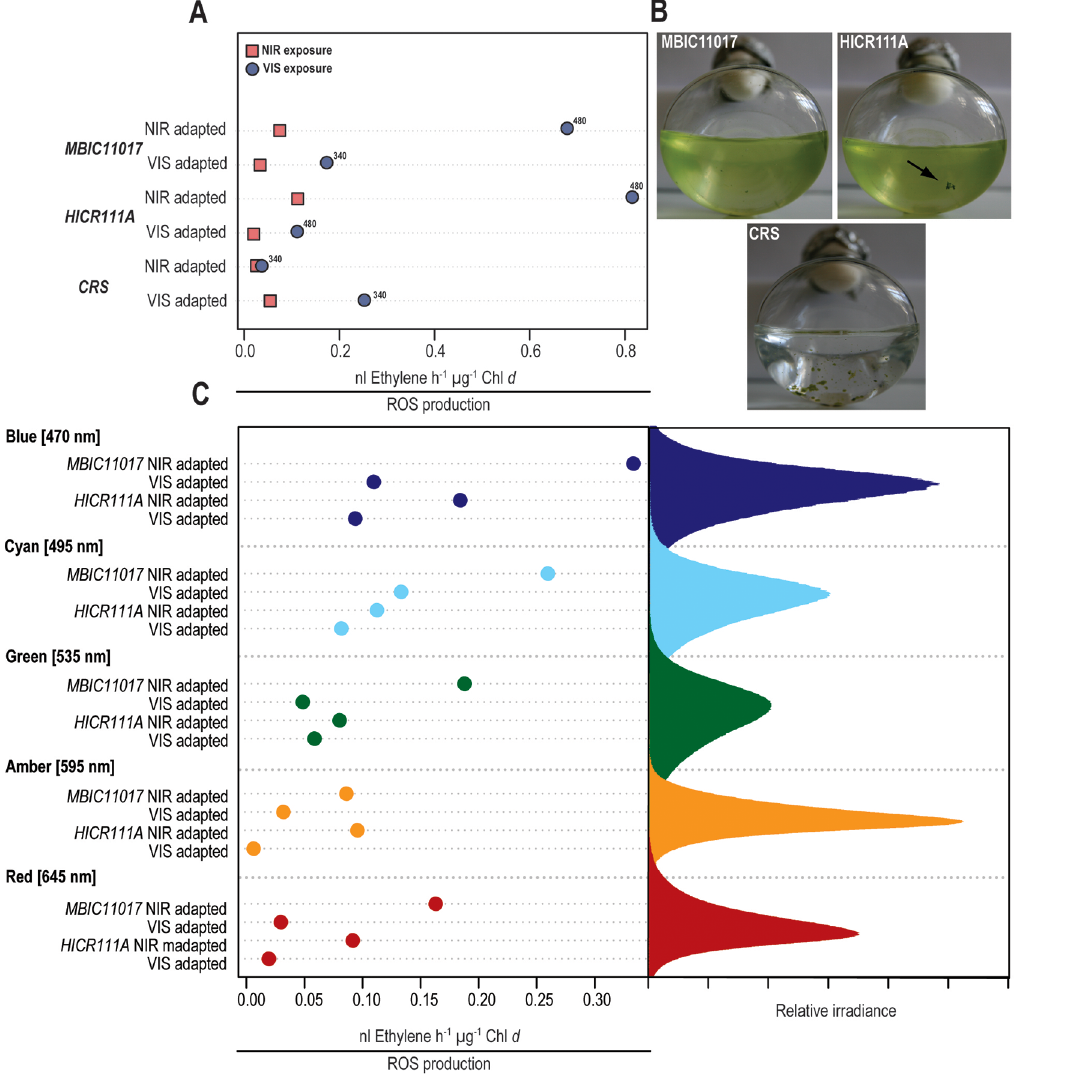
Figure 2. ROS induced ethylene production in the three Acaryochloris sp . strains MBIC11017, HICR111A and the novel strain CRS . All values were normalized to Chl d concentration as determined by spectrophotometry. All cultures were grown under either near-infrared radiation (NIR, 720 nm) or visible light (VIS, 400–700 nm) before subsequent light exposure. ( A ) Cleveland dot-plot of ROS levels measured during exposure of VIS or NIR adapted Acaryochloris cells to either VIS (blue dots, 340–480 µmol photons m -2 s -1 , as denoted on the graph) or NIR (red squares, 400 µmol photons m -2 s -1 ). ( B ) Action spectrum of ROS-induced ethylene production in VIS or NIR adapted strains MBIC11017 and HICR111A. Due to lack of sufficient culture material, action spectra were not determined for Acaryochloris strain CRS. Peak emissions of the monochromatic LEDs used for illumination were: red (645 nm), amber (595 nm), green (535 nm), cyan (495 nm) and blue (470 nm). The irradiance in this experiment was adjusted to 300 µmol photons m -2 s -1 . ( C ) Growth forms of the different Acaryochloris strains MBIC11017, HICR111A and CRS. All strains displayed were grown under NIR and are approximately one week old. Please note the natural formation of biofilms in Acaryochloris strain HICR111A (arrow) and CRS.